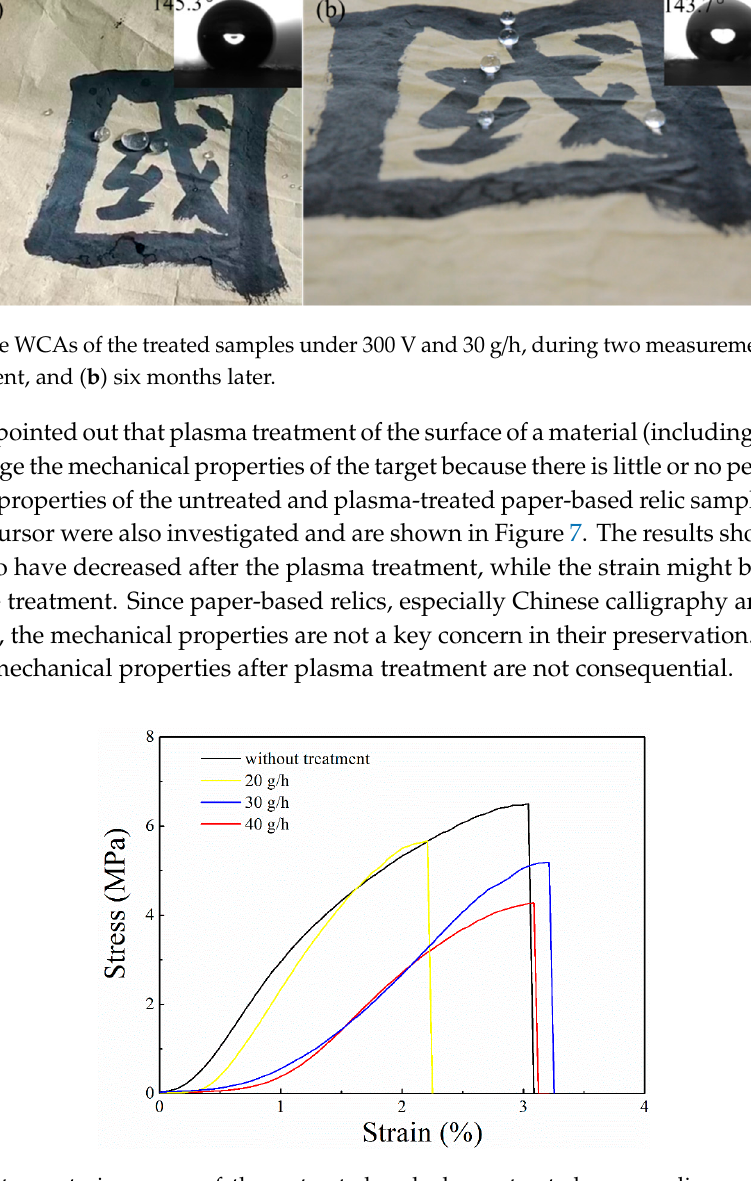
Figure 7. Stress–strain curves of the untreated and plasma-treated paper relics under different parameters (Color online) .